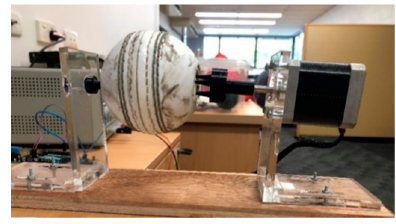
Figure 3. Microcontroller calibration